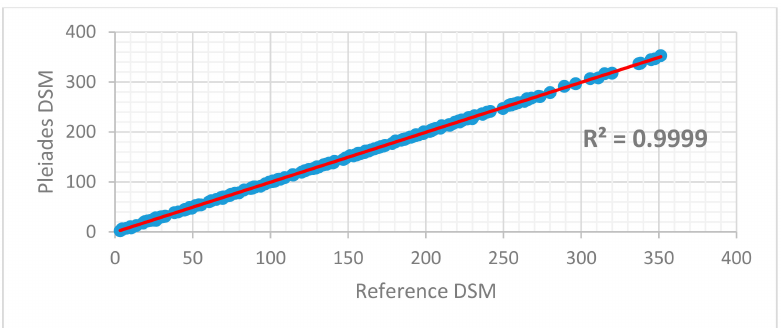
Figure 7. Scatter plot of Pleiades-reference DSM difference vs. elevation. No important bias is being observed.